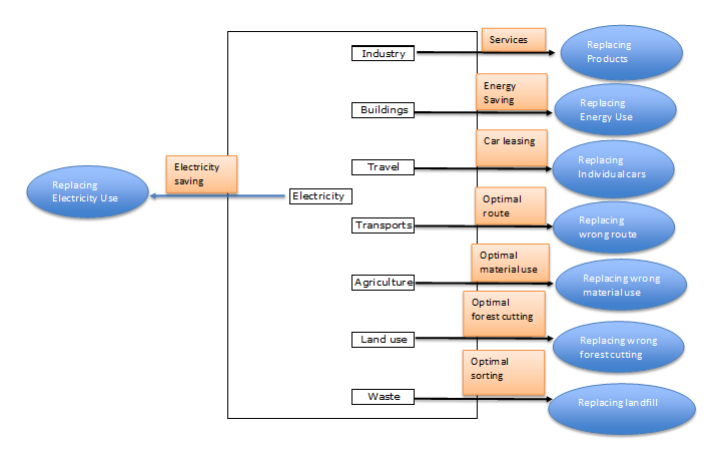
Figure 1. Consequential handprint principle of ICT